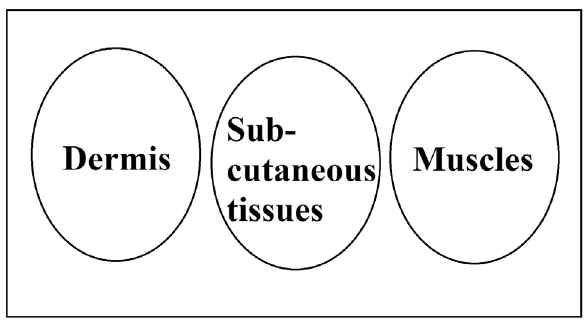
Figure 2. Compartments of the Biological